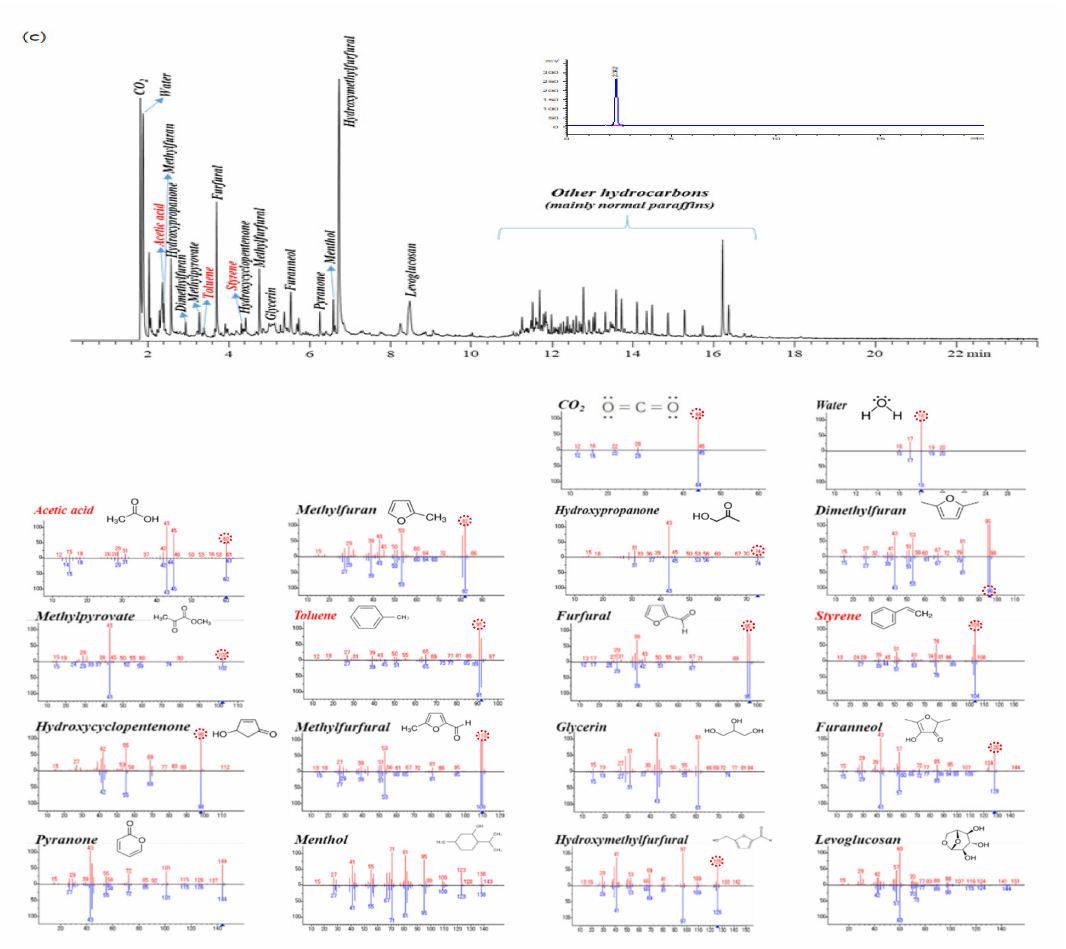
Figure 3. Total ion chromatograms of the PVAc reference standard ( a ), positive sample gum ( b ), and negative sample gum (no PVAc) ( c ) obtained from the Py–GC–MS analysis and a chromatogram